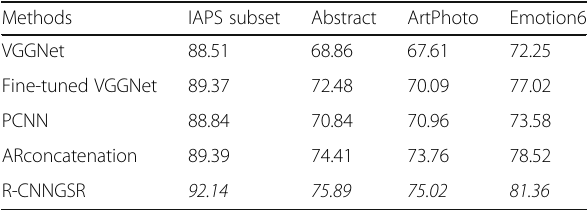
Table 2 Performance comparison between R-CNNGSR and the state-of-the-art